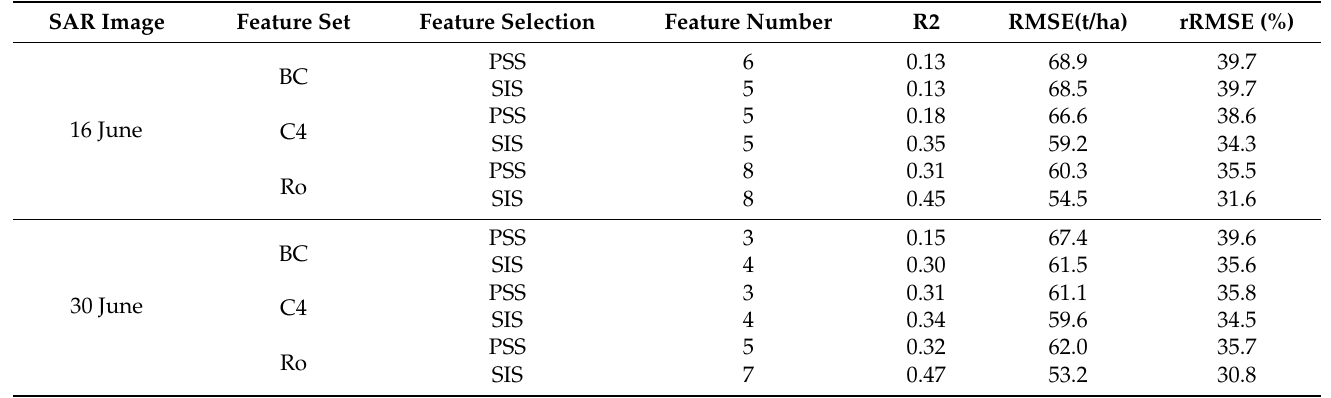
Table 5. Results of estimated forest AGB using two feature selection methods with three types of feature sets.